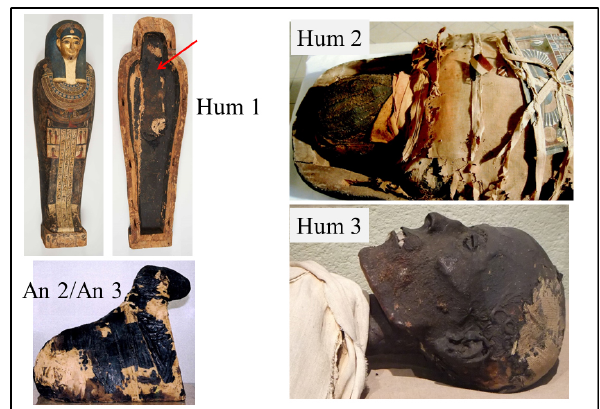
Figure 1. Origin of some samples of black matter studied by EPR: (Hum 1) coffin of Irethorerou (Ptolemaic dynasty), Art and History Museum, Narbonne, France (C2RMF76267, images cha17156 and cha17158). The black matter was sampled at the bottom of the coffin (arrow). ©C2RMF/Anne Chauvet. (Hum 2) Human mummy of the Late Period, Hieron Museum, Paray-le-Monial, France. The sam- ple is a fragment of black matter covering the mummy. ©Hélène Guichard. (Hum 3) Head of the mummy from the Late Period, Chateau-musée, Boulogne, France. The sample was taken from the mummy’s neck and reproduced with permission. ©Frédérique Vin- cent. (An 2/An 3) Ram mummy of the Late Period, Thomas Do- brée Museum, Nantes, France (Inv. D 961.2.140). The An2 and An3 samples are a fragment of black matter and a fragment of tis- sue with brown matter, respectively. ©Dépôt du musée du Louvre/- Musée Dobrée-Grand Patrimoine de Loire-Atlantique.